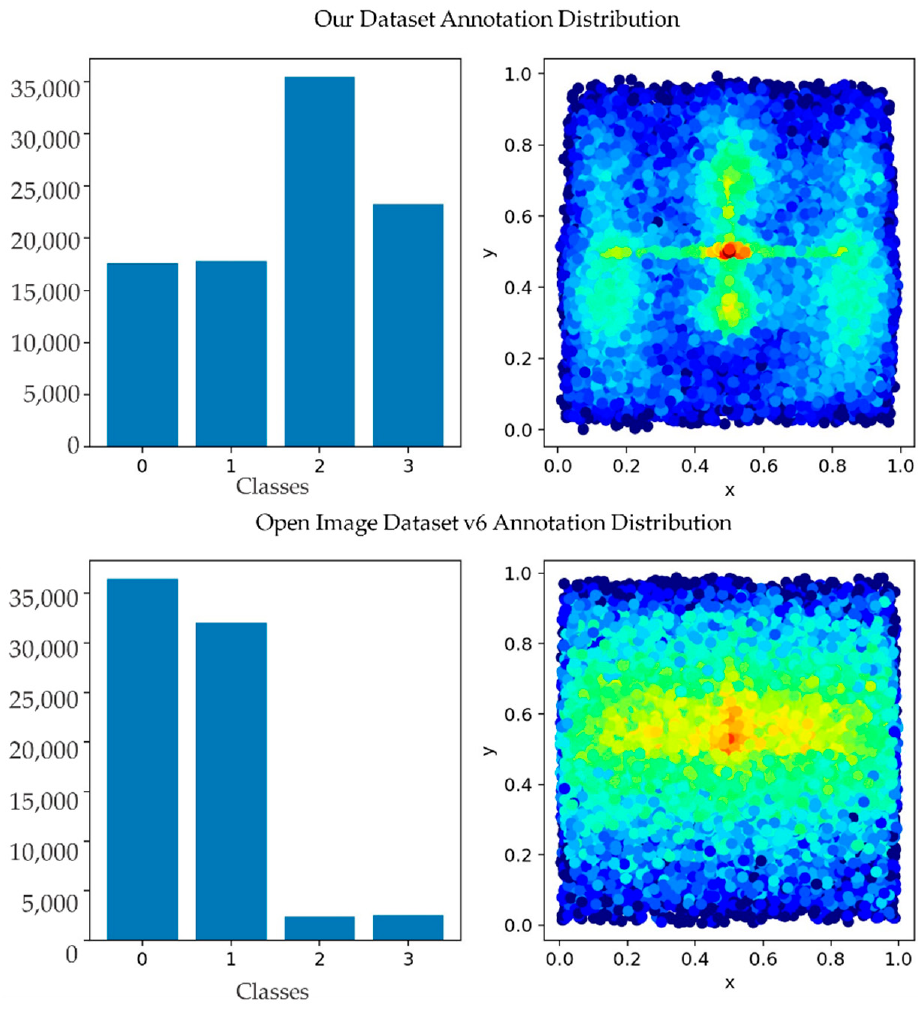
Figure 9. Comparison of class representation between the PGC dataset and open v6.